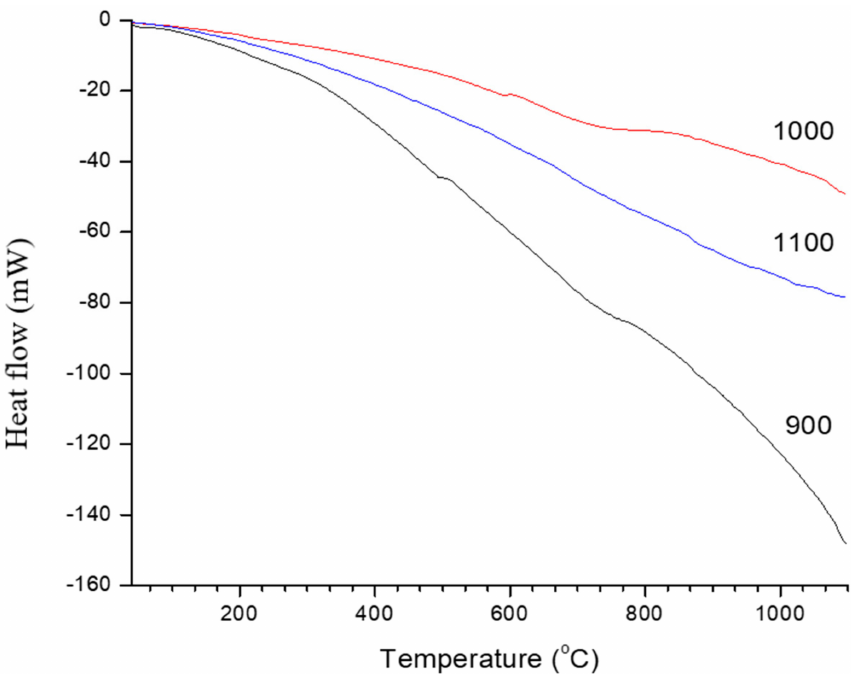
Figure 8. Differential scanning calorimetry (DSC) analysis of sintered kaolin-GGBS